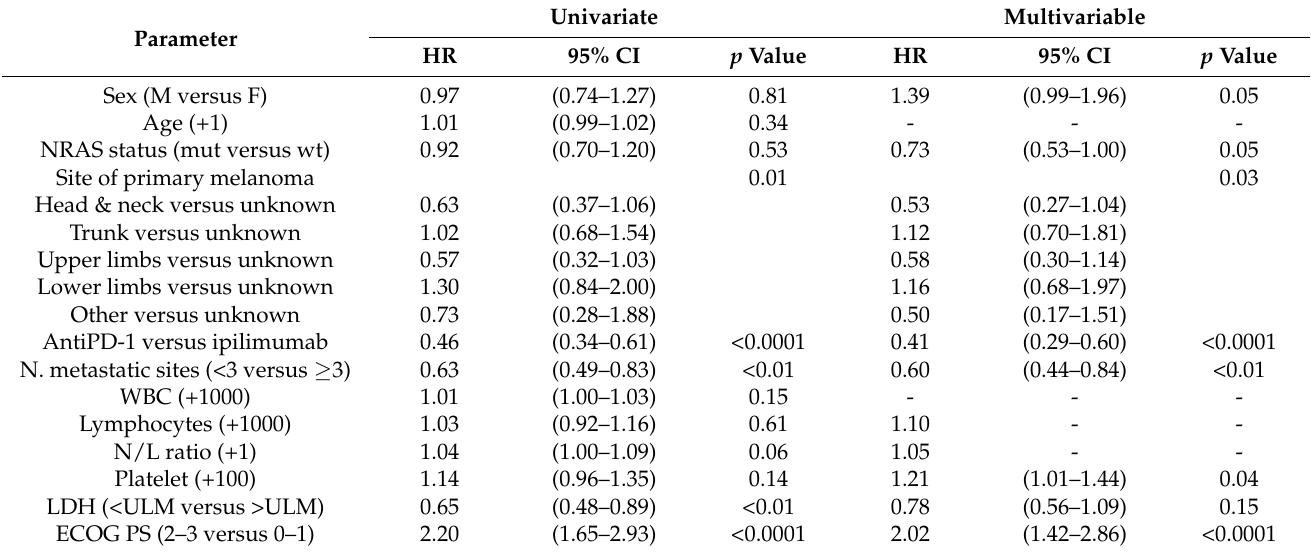
Table 7. Univariate and Multivariable analysis of progression-free